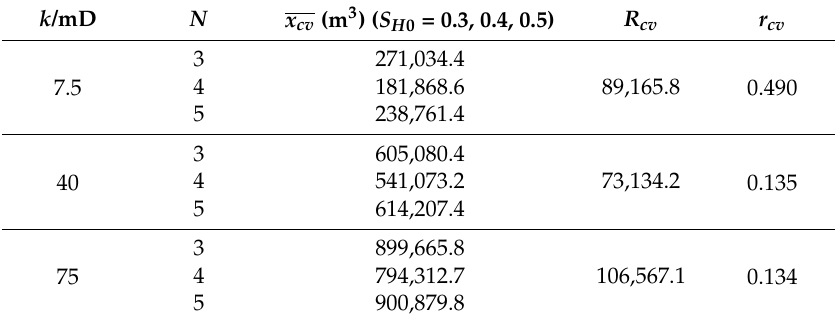
Table 11. Range analysis of Q cv of variably N in different k